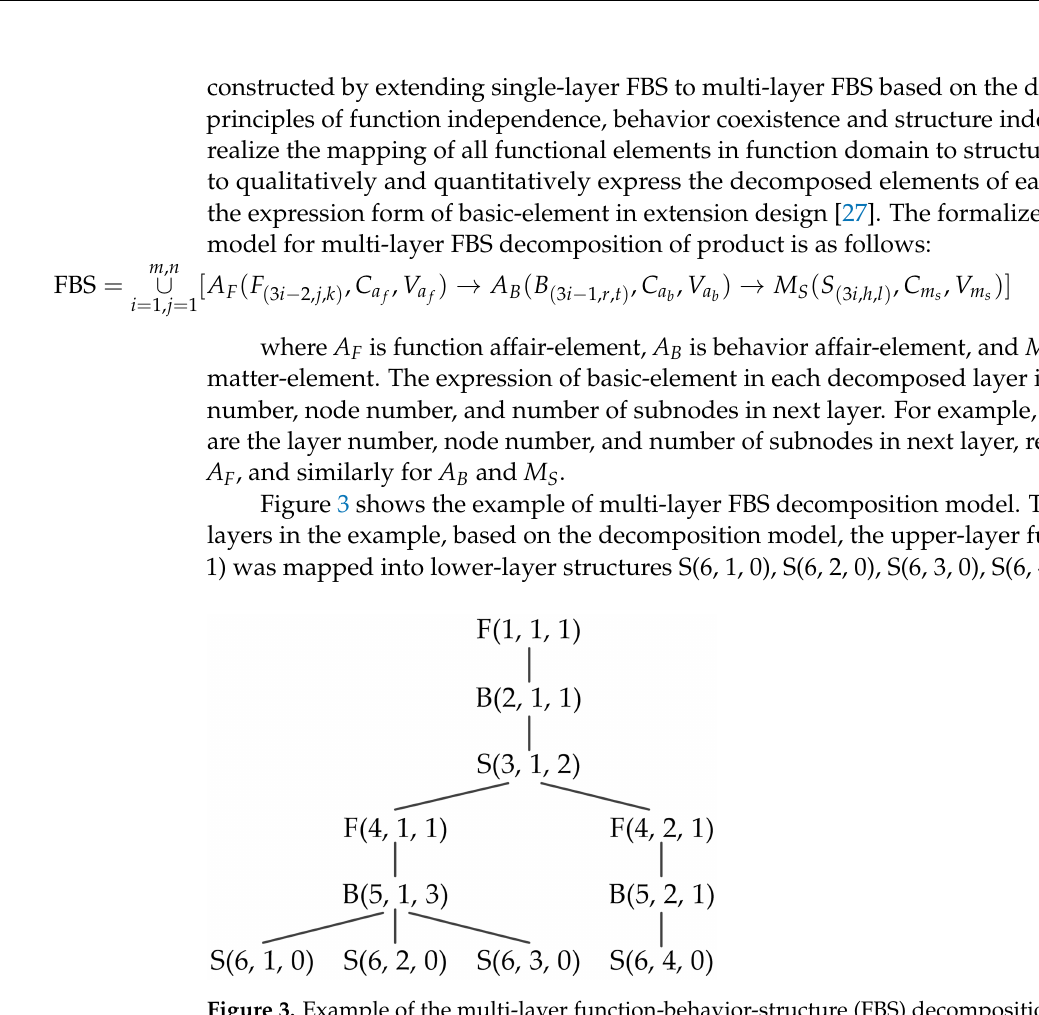
Figure 3. Example of the multi-layer function-behavior-structure (FBS) decomposition